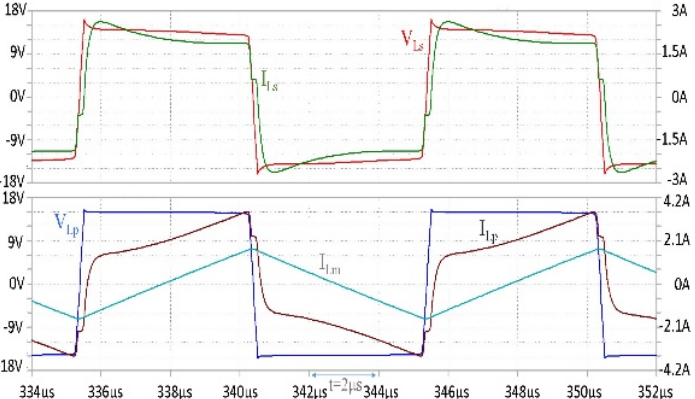
Figure 14. Simulation results in steady state of a switching leg. Up ‐ side, the gate voltage of Q 1 (V GS1 ) and Q 2 (V GS2 ). Down ‐ side the V HF2 voltage corresponding to the V DS2 across Q 2 . Time t = 2 μ s/div.